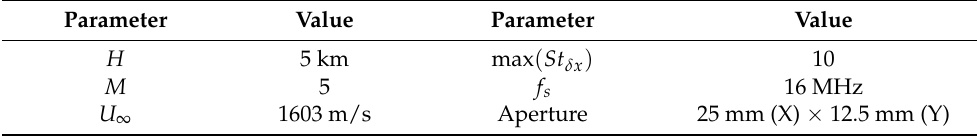
Figure 9. The three-dimensional density field in TSAO. Table 1. The flow condition and simulation parameters.